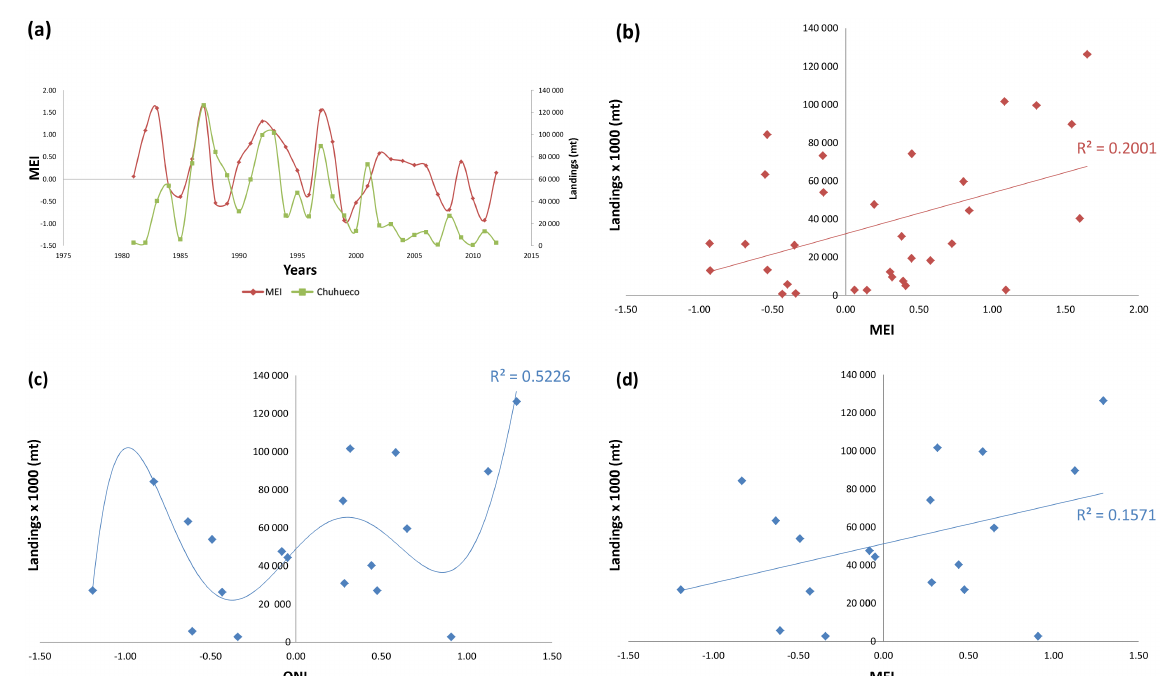
Figure 9. Chub mackerel (macarela) landings (1981–2012) vs. the MEI.